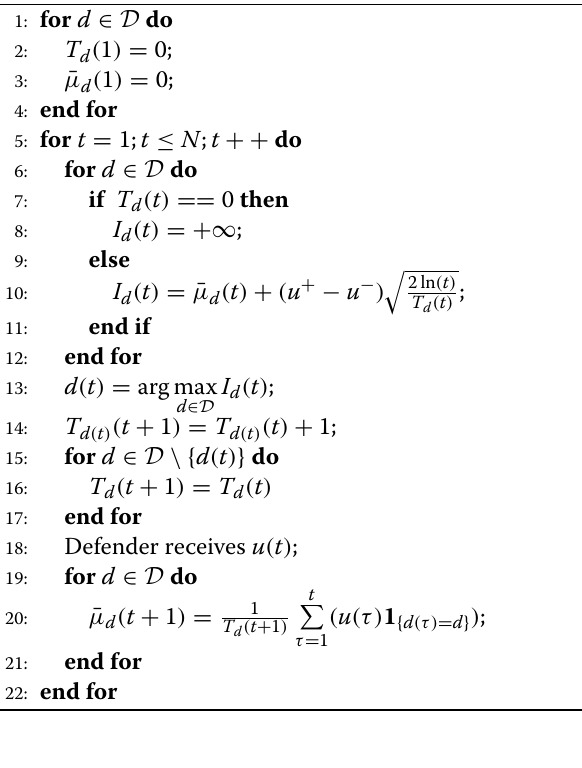
Algorithm 1 The UCB-D